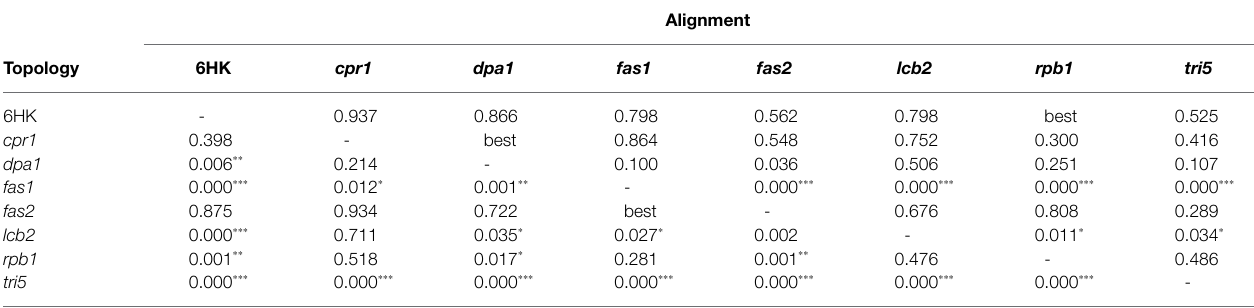
A value of pSH < 0.05 indicates that a tree inferred from another alignment was a significantly worse fit than the original tree. One asterisk ( * ) indicates p values of 0.01–0.05, two asterisks ( ** ) indicates p values of 0.0010–0.0099; and three asterisks indicate p values < 0.001. Note that for all housekeeping gene alignments, the tri5 tree topology can be discarded (pSH < 0.05) with the data of any of the HK genes, i.e., it was a worse fit than the original housekeeping gene trees. However, the best topologies, 6HK, cpr1 and fas2 tree topologies, can not be discarded (pSH > 0.05) by any of the alignments.